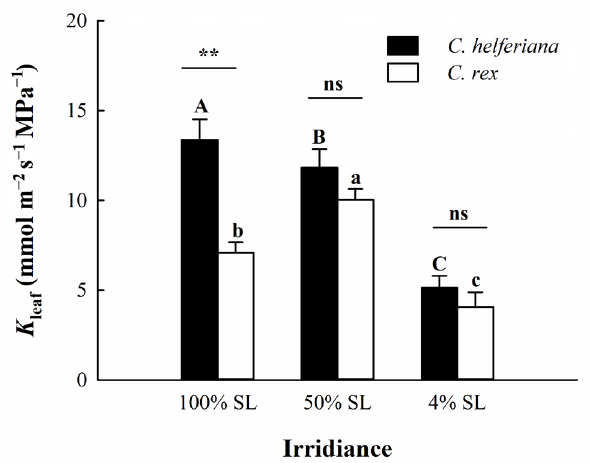
Figure 3. Leaf hydraulic conductance ( K leaf ) of C. helferiana and C. rex seedlings grown under three different light conditions. Data are means ± 1SE ( n = 4). Different capital and lowercase letters on top of bars indicate significant differences ( p < 0.05) between different growth light intensities within the species. “**” and “ns” indicate significant difference ( p < 0.01) and non-significant difference, respectively, between different species under the same growth light treatment.